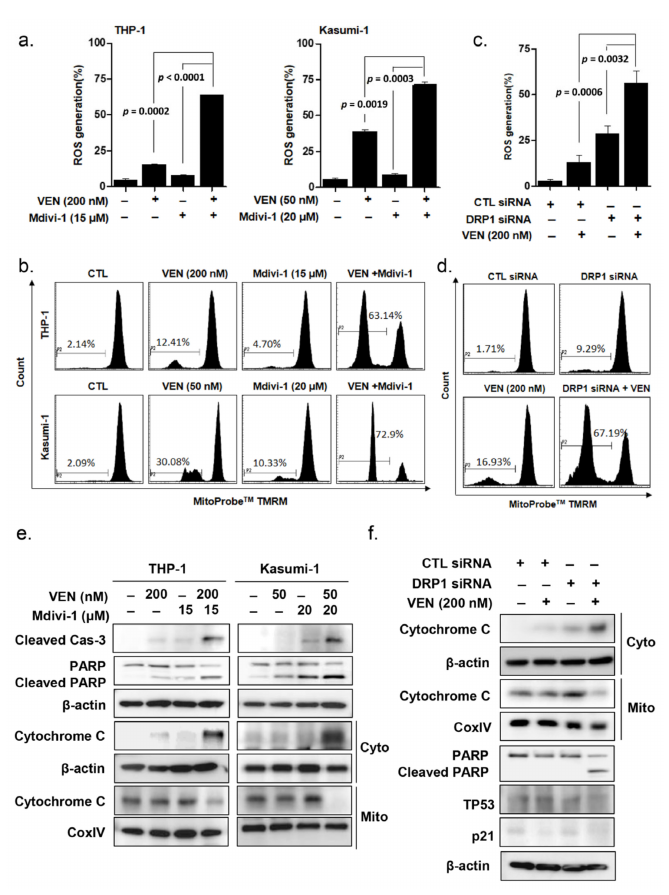
Figure 4. DRP1 inhibition enhances venetoclax-induced ROS generation and mitochondria-mediated apoptosis in TP53mut leukemia cells. ( a – c ) THP-1 and Kasumi-1 cells were treated with 200 or 50 nM venetoclax in the presence or absence of 15 or 20 µ M Mdivi-1, respectively. ( a ) After incubation for 24 h, intracellular ROS generation was measured using flow cytometry analysis. Data are the mean ± SD of three independent experiments. ( b ) After incubation for 48 h, the mitochondrial membrane potential in THP-1 and Kasumi-1 cells loaded with TMRM was detected using flow cytometry. ( c , d ) THP-1 cells were transfected with DRP1 siRNA or CTL siRNA after incubation of transfected cells with 200 nM venetoclax. ( c ) After incubation for 24 h, intracellular ROS generation was measured using flow cytometry analysis. ( d ) After incubation for 48 h, mitochondrial membrane potential in THP-1 cells loaded with TMRM was detected using flow cytometry. ( e ) After incubation for 48 h, the cytosolic (Cyto) and mitochondrial (Mito) fractions were prepared and subjected to Western blotting using an antibody against cytochrome C. Total cell lysates were subjected to Western blotting using the indicated antibodies. β -Actin was used as a loading control. COX IV and β -Actin were used as mitochondrial and cytosolic marker proteins, respectively. ( f ) THP-1 cells were transfected with DNM1L/Drp1 siRNA or control siRNA. After incubation of transfected cells with 200 nM venetoclax for 48 h, the Cyto and Mito fractions were prepared and subjected to Western blotting using an